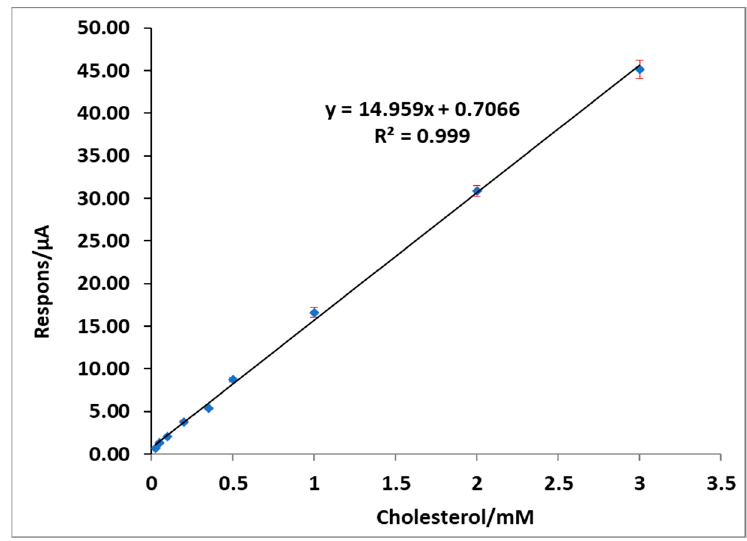
Figure 7. Corresponding calibration plot for